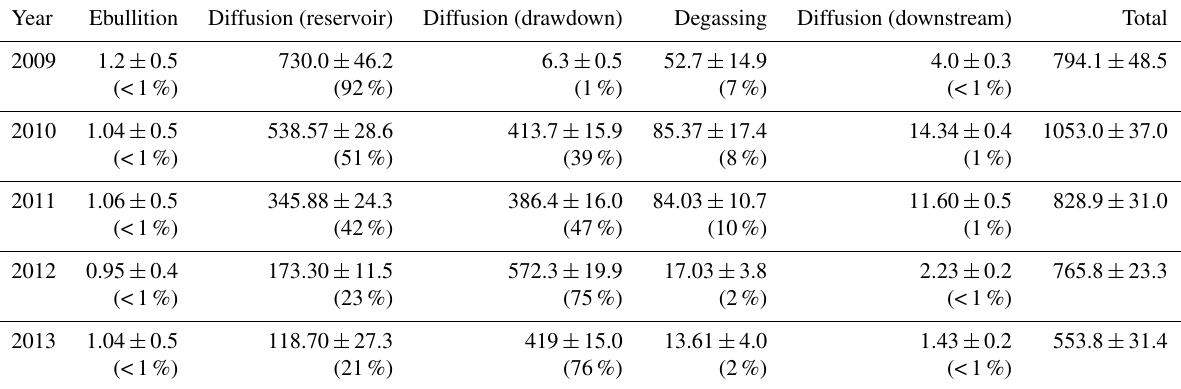
Table 3. CO 2 emissions (in GgCO 2 year − 1 ) from the Nam Theun 2 Reservoir (Lao PDR) for the first 5 years after impoundment (2009, 2010, 2011, 2012 and 2013). Percentages between brackets represent the proportion of each component to the total annual